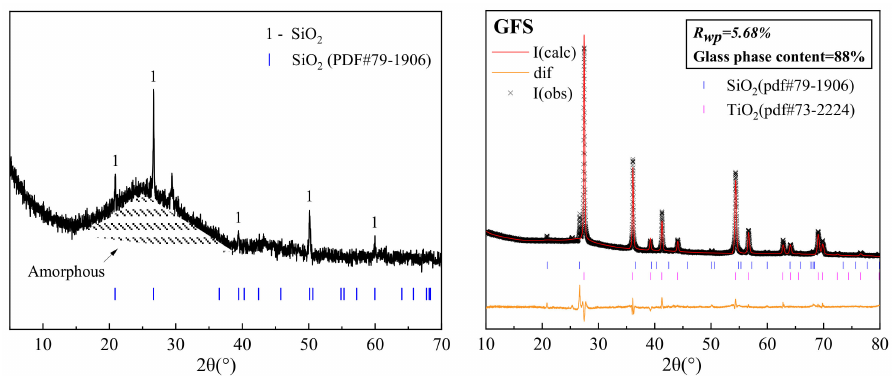
Figure 5. Analysis of the XRD ( left ) and QXRD ( right ) pattern of the GFS powder.